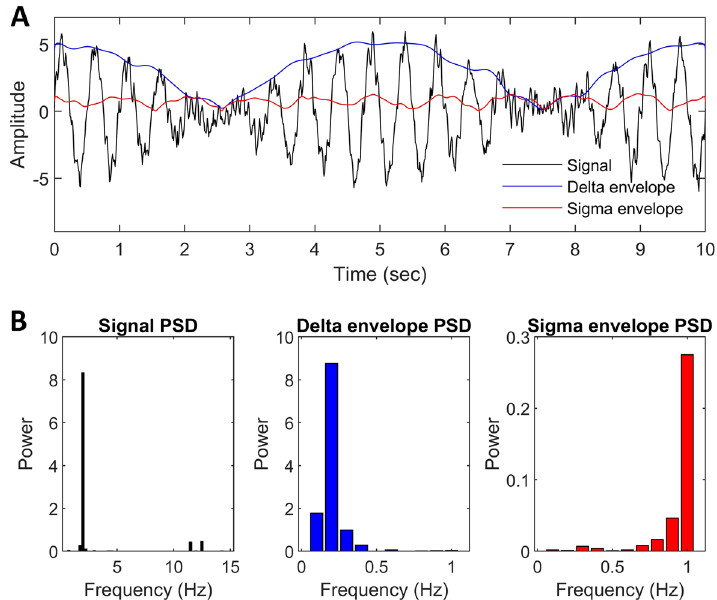
Figure 1. The principle of EEG envelope spectrum analysis. ( A ) Shows a simulated EEG signal, consisting of the sum of a 2 Hz sinusoid modulated by a 0.2 Hz carrier frequency, a 12 Hz sinusoid modulated by a 1 Hz carrier frequency, and pink noise. Overlain blue and red lines show the instantaneous amplitude or envelope (modulus of the Hilbert transform) of the delta (1–4 Hz) and sigma (10–16 Hz) frequency ranges, respectively. ( B ) Shows the power spectral density of the original signal (left) and the delta (middle) and sigma (right) envelopes. Note that the carrier frequencies are accurately recovered from spectral analysis of the envelopes (with some impurities due to added noise and the fact that the modulus of the Hilbert transform of a modulated signal is not fully sinusoidal). The spectrum of the envelope reveals periodic fluctuations in the amplitude of higher-frequency